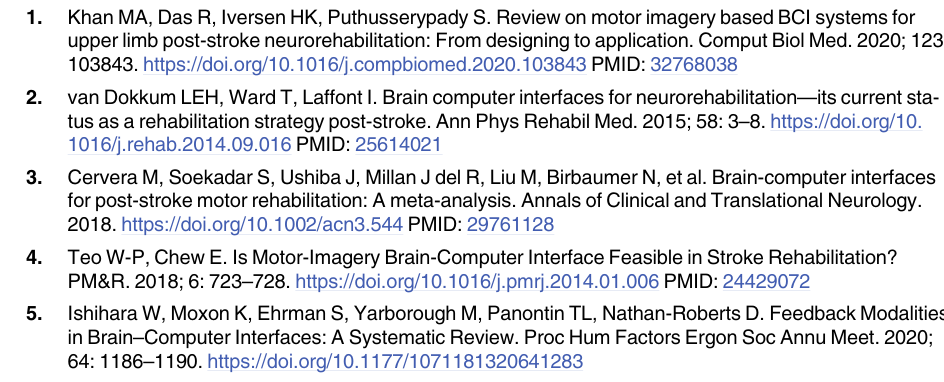
S1 Fig. High-gamma oscillations during proprioceptive stimulation. (A) Spatial topography of high-gamma (40–100 Hz) frequencies during rest, preparation and MI in the first two experimental runs of Data 2. (B) Time-frequency plots for frequencies 40–100 Hz, averaged over frontal gradiometers, in the first two runs of Data 2.